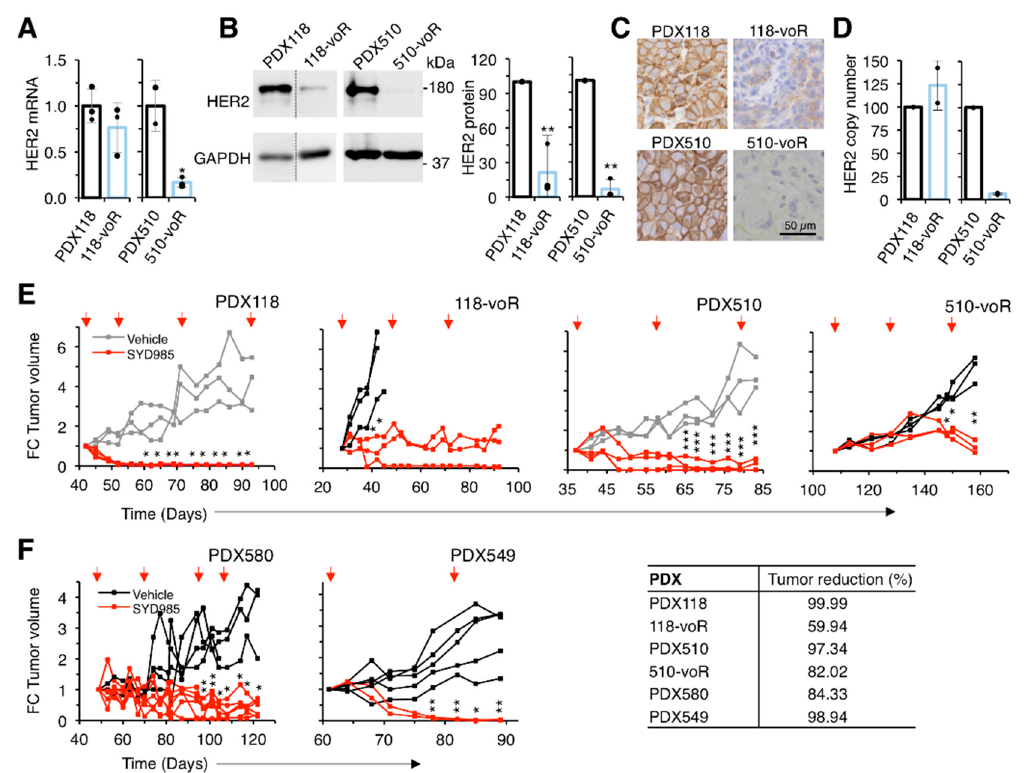
Figure 5. Characterization of in vivo resistant models and e ff ect of SYD985. ( A ) Relative HER2 mRNA expression was determined by qRT-PCR. Data were normalized to GAPDH mRNA. Averages and standard deviation of three independent determinations are represented; ( B ) Lysates were analyzed by Western blot with the indicated antibodies (left panel) and densitometrical quantification was performed (right panel). Quantitative results are expressed as averages ± standard deviations of three independent experiments. ** p < 0.01, two-tailed Student’s t -test; ( C ) Immunohistochemical analysis of the expression of HER2; ( D ) HER2 gene copy number determination by qPCR; ( E , F ), NOD / SCID mice carrying the indicated PDXs were treated with vehicle or SYD985 as indicated. Tumor volume was determined and expressed as fold-change relative to the initiation of treatment. Note that the volumes corresponding to PDX118 and PDX510, depicted in gray, treated with vehicle are the same as those shown in Figure 1D. In order to minimize the number of mice used, treatments with T-DM1 and SYD985 were done in the same experiment, although they are presented in di ff erent figures. Tumor reduction was calculated at the end of the experiment as the percentage of the average tumor volumes of the tumors treated with SYD985 relative to tumors treated with vehicle. * p < 0.05, ** p < 0.01, *** p < 0.001 two-tailed Student’s t ‐ test.